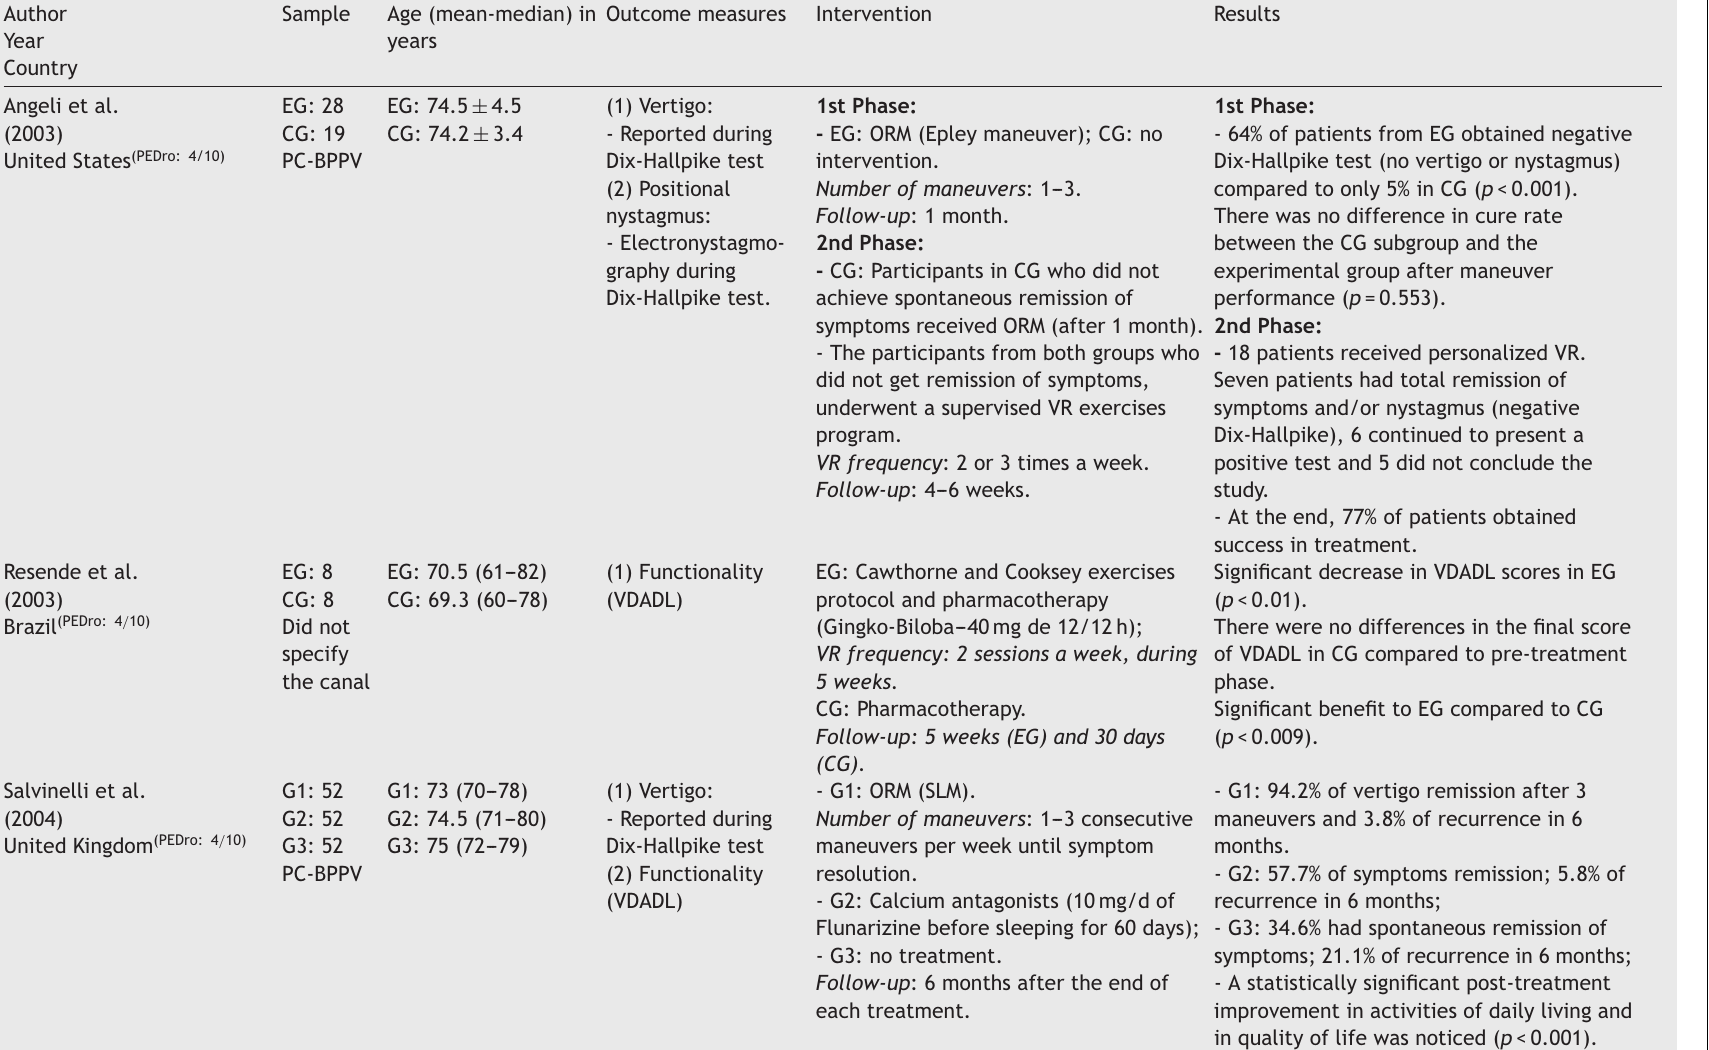
Table 1 Synopsis of data from randomized controlled clinical trials about the effectiveness of Otolith Repositioning Maneuvers (ORM) and Vestibular Rehabilitation (VR) exercises in the treatment of Benign Paroxysmal Positional Vertigo (BPPV) in elderly